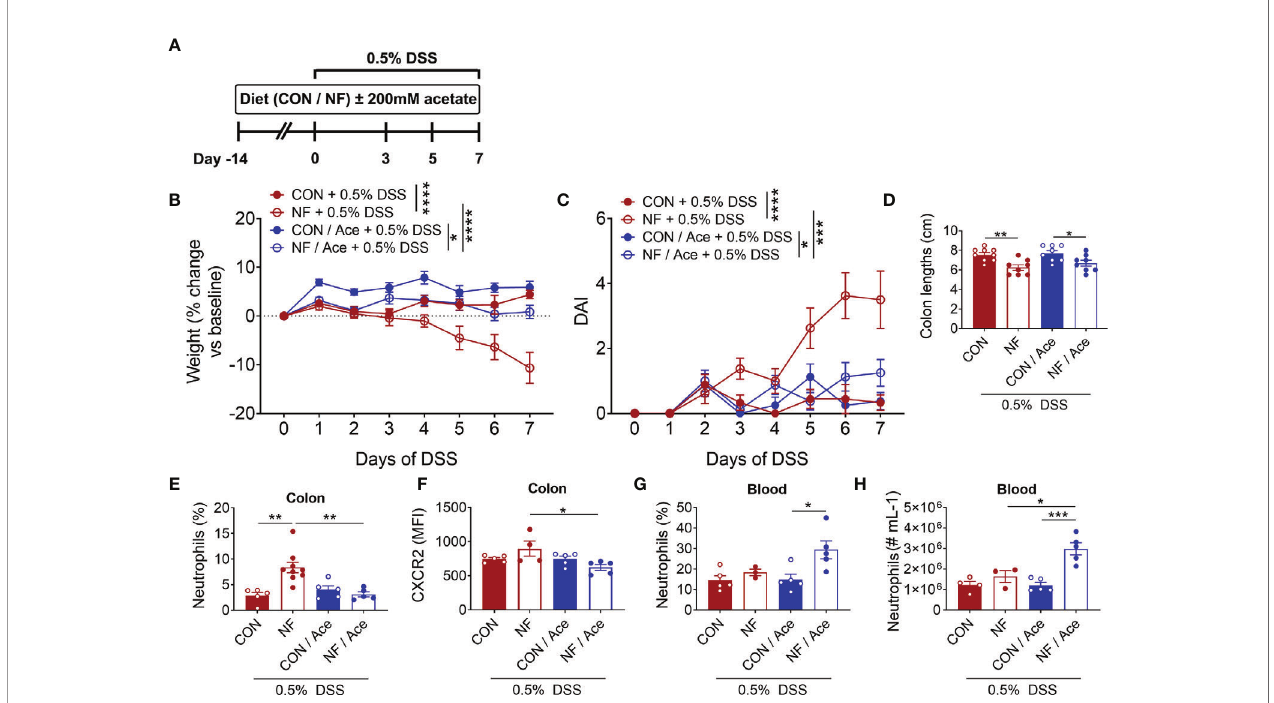
FIGURE 7 | Effect of supplementing acetate with NF diet on development of DSS-induced colitis. (A) WT mice were supplemented with 200 mM acetate in drinking water in addition to either a control (CON) or no fi ber (NF) diet for 14 days prior to and during 0.5% DSS-induced colitis. There was daily monitoring of (B) weight (N ≥ 8 per group) and (C) DAI (N ≥ 8 per group) during 0.5% DSS-induced colitis. (D) At day 7 of 0.5% DSS-induced colitis, mice were culled, and colon length was measured (N ≥ 8 per group). The colon was collected, and neutrophils were quantitated by fl ow cytometry using fl uorescent counting beads. The proportion (E) and expression of CXCR2 (F) on neutrophils in the colon and blood (G, H) were enumerated. Data displayed as mean ± SEM, N ≥ 3 per group. Two-way ANOVA was performed for all data across all time point for (B, C) . Student ’ s t -test was performed for (D – H) , * P < 0.05, ** P < 0.01, *** P < 0.001, **** P <